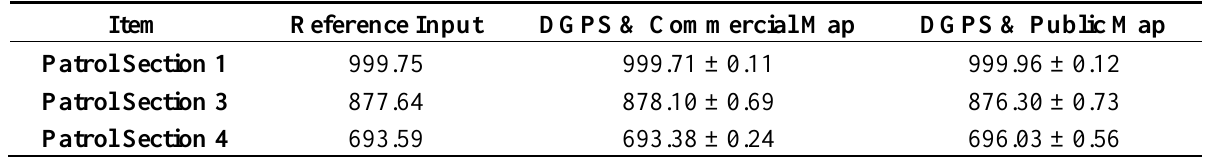
Table 4. The first sensitivity analysis: “Quantity of salt used for all event and each patrol section (kg).”